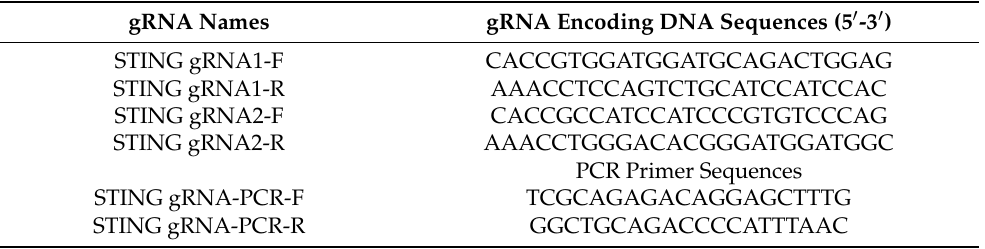
Table 2. The CRISPR gRNA encoding DNA sequences and PCR primers for monkey STING genes. gRNA